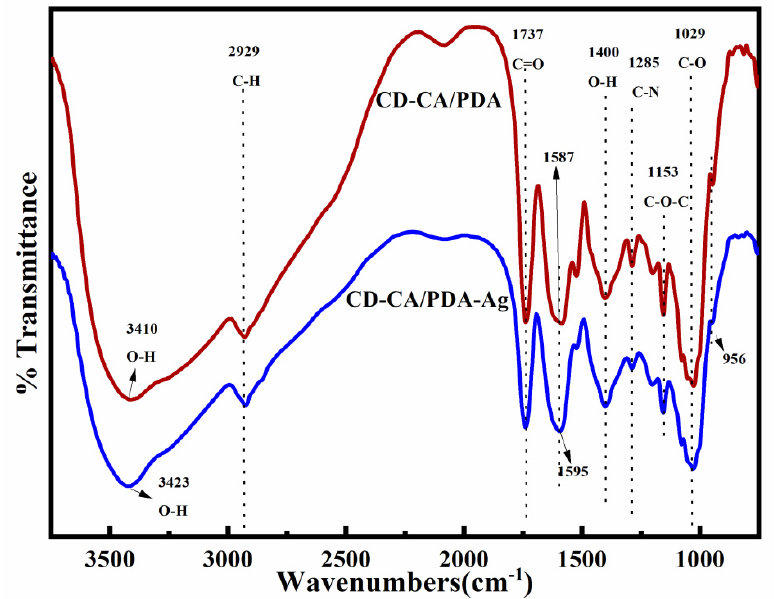
Figure 2. FT-IR analysis of CA-CA/PDA before and after loading AgNPs.